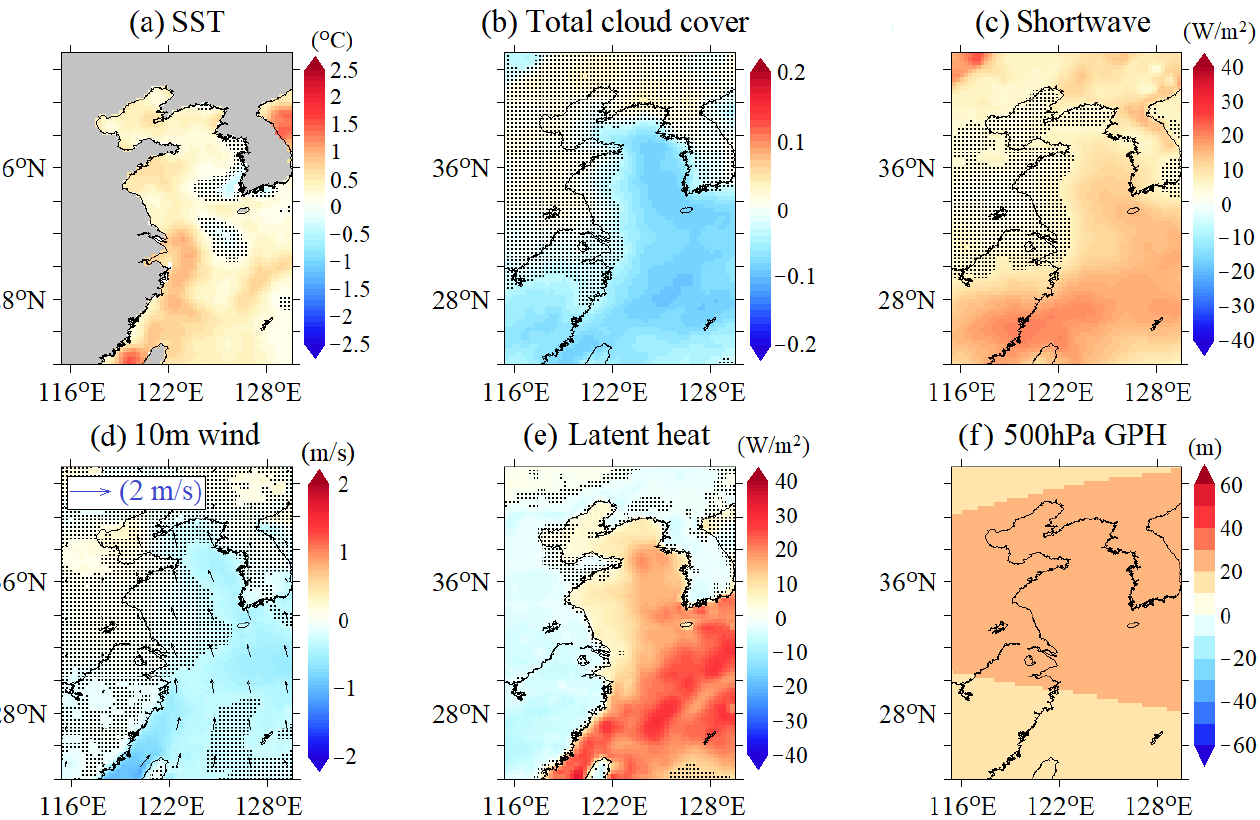
Figure 7. Composite differences during the top third (strong) and the bottom third (weak) MHW characteristics (duration, coverage, mean intensity) in YECS in winter (strong–weak). ( a ) Sea surface temperature, ( b ) total cloud cover, ( c ) shortwave radiation, ( d ) 10 m wind speed and direction, ( e ) latent heat flux (downward positive), and ( f ) 500 hPa geopotential height. The dotted areas indicate insignificant values at a 95% confidence level using Student t -test ( p -value > 0.05).